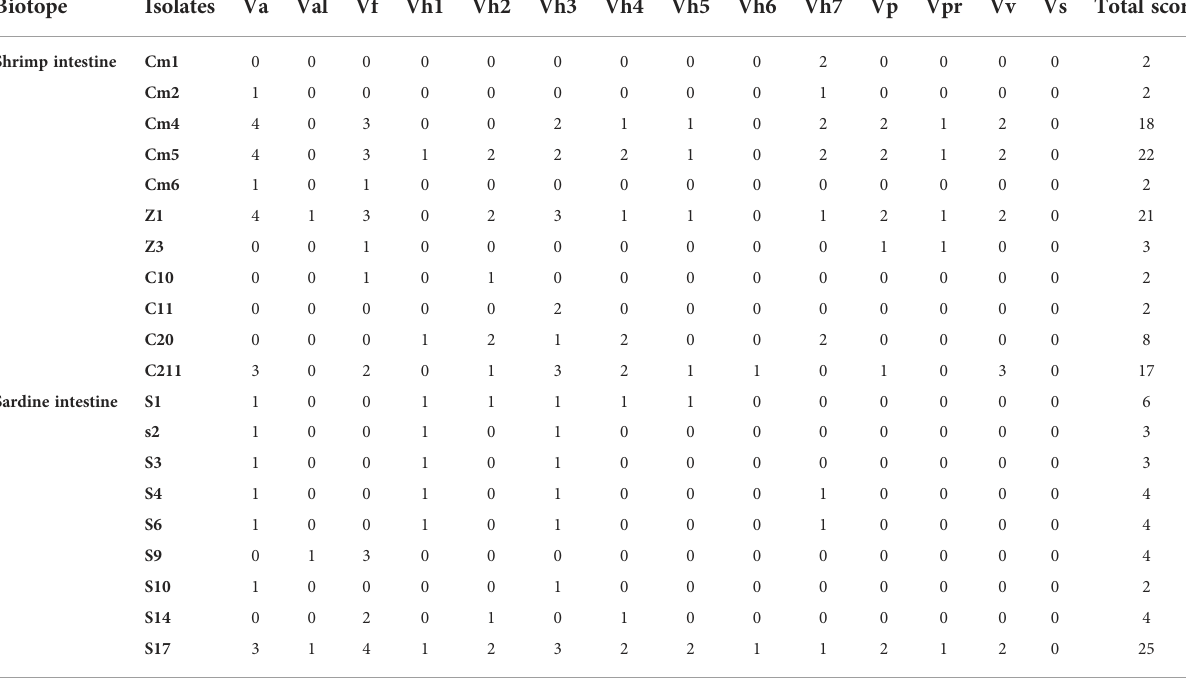
TABLE 2 Direct antimicrobial activity against fi sh pathogens. Biotope